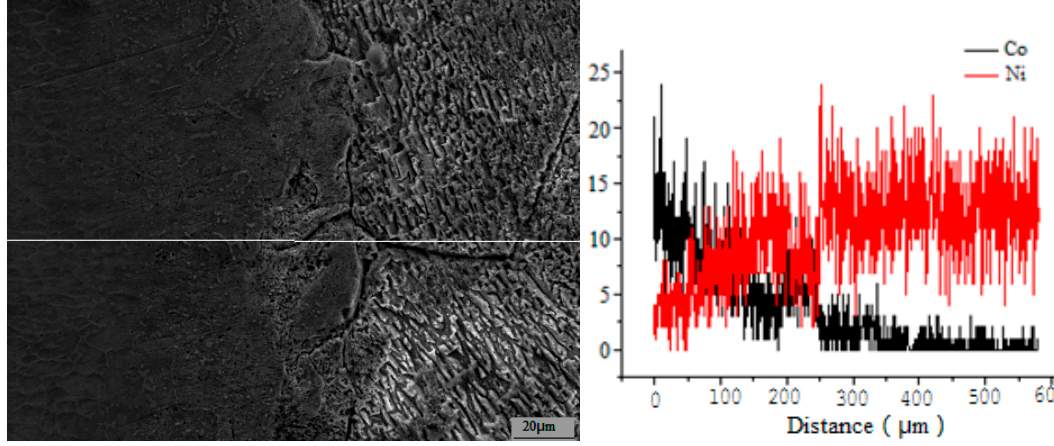
Figure 7. Distribution of Co and Ni along the cross ‐ section of the Ni–Co duplex coating.